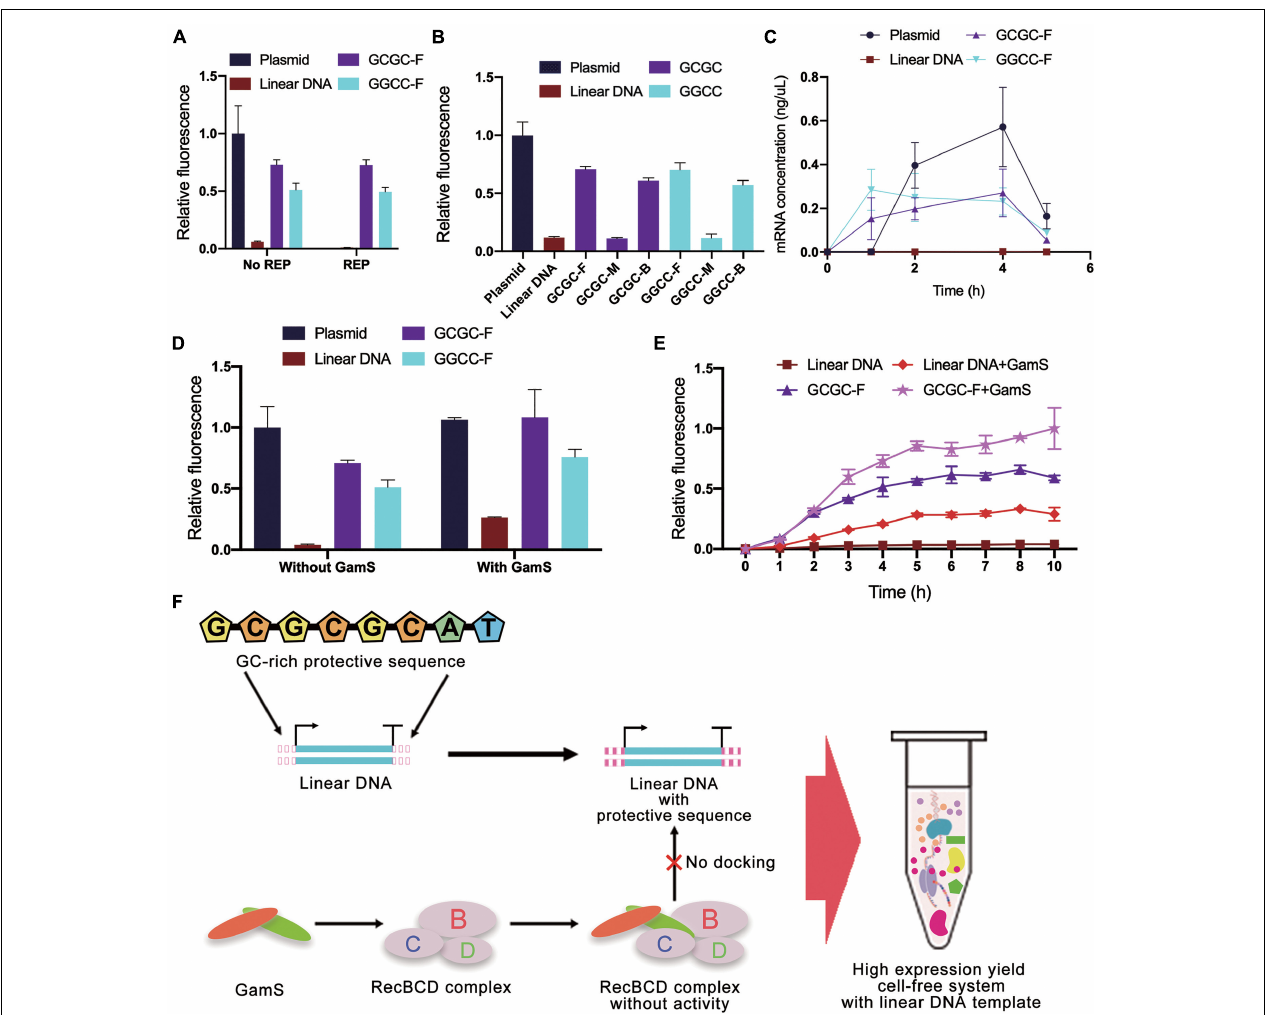
FIGURE 7 | Cell-free experimental verification of protective sequence design. (A) Comparison of typical templates and linear templates with REP sequence. The REP sequence used was the REP sequence number 17. Only the plasmid group did not add the REP sequence. Linear DNA meant the linear expression templates did not add protective sequences. The GCGC meant protective sequences with GCGC arrangement mode were added to the linear expression templates. The GGCC meant protective sequences with GGCC arrangement mode were added to the linear expression templates. The GC distribution mode of these protective sequences was front. The fluorescence of the cell-free system with plasmid was set to 1. Error bars represented standard deviations from three replicates. (B) Experimental results of different expression templates in cell-free systems. The letters F, M, and E meant GC distribution mode was front, middle, and back. The fluorescence of the cell-free system with plasmid was set to 1. Error bars represented standard deviations from three replicates. (C) The kinetics of cell-free reactions with different expression templates. Error bars represented standard deviations from three replicates. (D) Comparison of sequence-based protection and GamS-based inhibition. The fluorescence of the cell-free system with normal plasmid was set to 1. Error bars represented standard deviations from three replicates. (E) Time curves of relative fluorescence for different protection strategies. The GC distribution mode of these protective sequences was front. The fluorescence of the cell-free system with the co-protection of protective sequence and GamS was set to 1. Error bars represented standard deviations from three replicates. (F) The co-protection of protective sequence and GamS inhibited the degradation from RecBCD complex. With the co-protection of the designed sequence and GamS, the protein expression yield of LDET-based cell-free systems could reach the same level as the plasmid-based cell-free